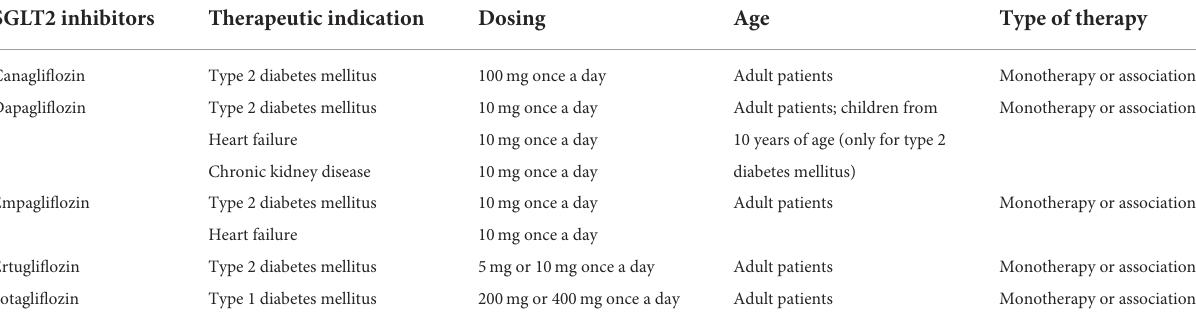
TABLE 1 Pharmacological characteristics of SGLT2 inhibitors available in the market. SGLT2